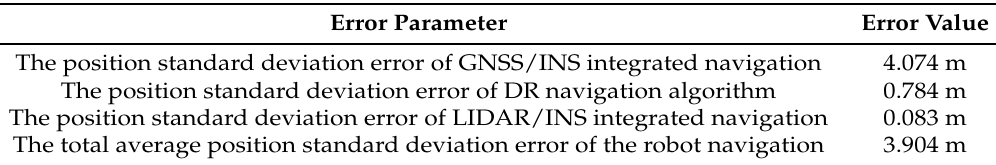
Table 1. Simulation robot navigation system experimental data